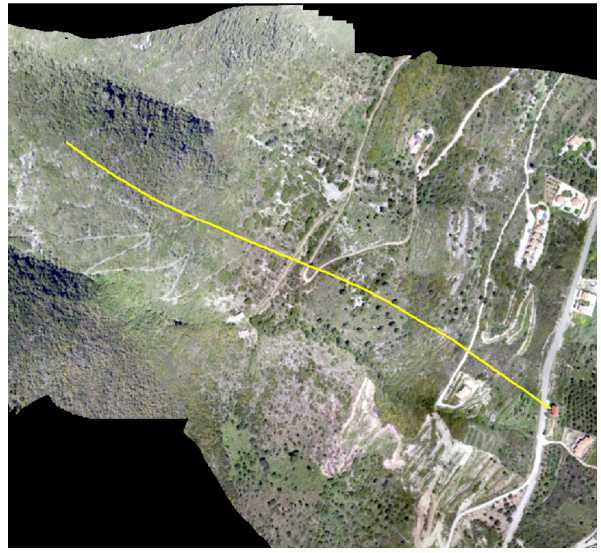
Figure 2. Orthophoto of case study. The total length of the trajec- tory shown with a yellow line is